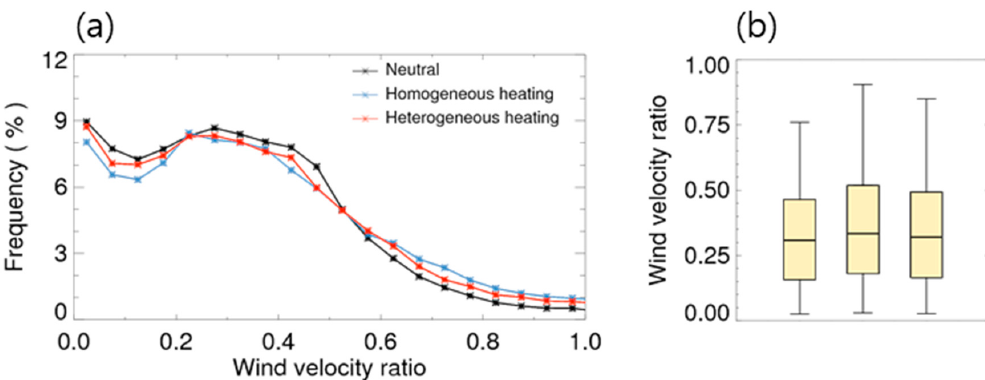
Figure 12. The comparison of the wind velocity ratio values simulated with no surface heating, homogeneous surface heating, and heterogeneous surface heating in ( a ) frequency distribution and ( b ) boxplot (left: no surface heating, middle: homogeneous surface heating, right: heterogeneous surface heating). The simulation results of 10–16 LST were analyzed in the plots.